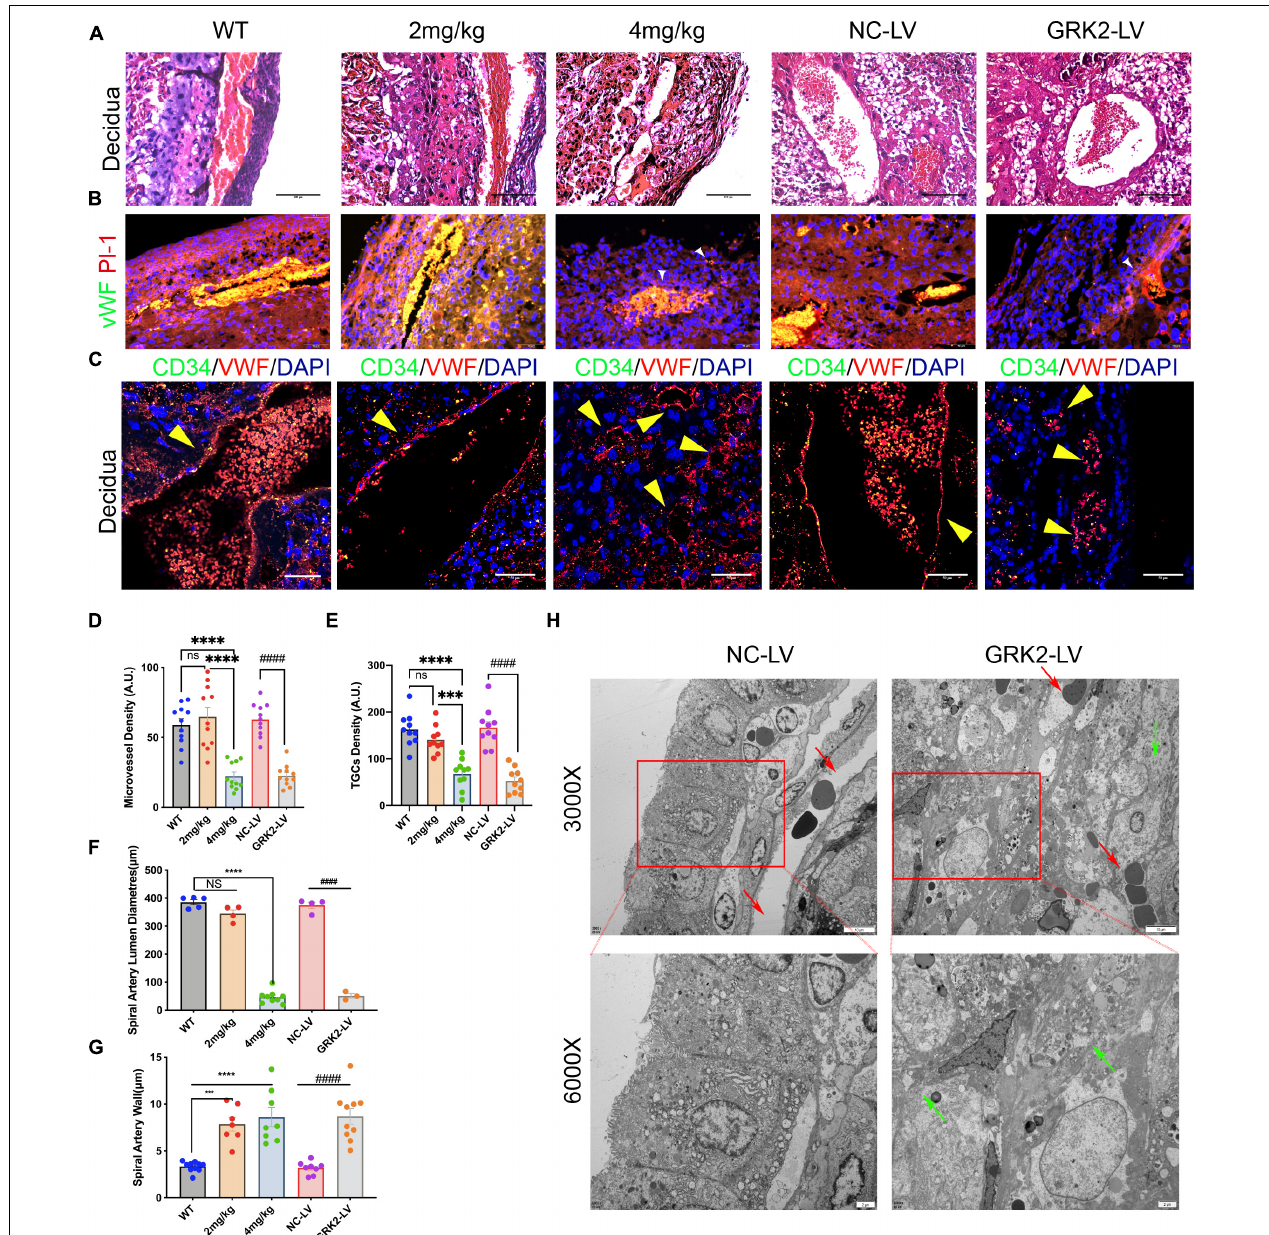
FIGURE 4 | Suppression of GRK2 in placenta induces para-vascular necrosis and failures of spiral arterial remodeling. (A) E18.5 embryo decidual sections were stained with H&E. panel. Scale bar, 100 µ m (B) Microvessels and trophoblast giant cells (TGCs) at E18.5 decidual-placental segments evaluated by vWF (endothelium, red) and Pl-1(parietal TGCs, green), respectively. White arrows (small vessels in GRK2-deficient group). vWF, von Willebrand factor; Pl-1, placental lactogen-1. Scale bar, 50 µ m (C) Co-staining of CD34 (green signals), vWF (red signals), and nuclei to detect the microvessel parameters of E18.5 embryos. Yellow arrows indicate spiral arterial wall. Scale bar, 50 µ m. (D,E) Quantity analysis of decidual microvessels and TGCs. (F,G) Morphometric analysis of spiral arteries. (H) The TEM images show impaired arterial remodeling with para-vascular necrotic lesions and cells. Red arrows, spiral artery; Green arrows, fragment membrane. From upper panel to bottom, 3,000 × , 6,000 × magnification, respectively. The ultrastructure of spiral arteries in GRK2-LV group was distorted, and its vascular lumen was almost closed. NS, not significant; ∗∗∗ P < 0.001, ∗∗∗∗ P < 0.0001 versus WT group; #### P < 0.0001 for NC-LV